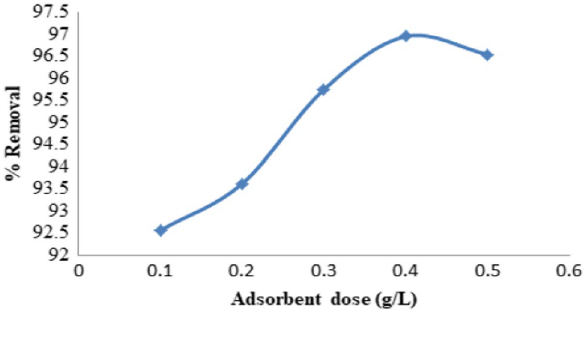
Fig. 2 Effect of adsorbent dos- age on MO dye removal using Anchote peel adsorbent at 25